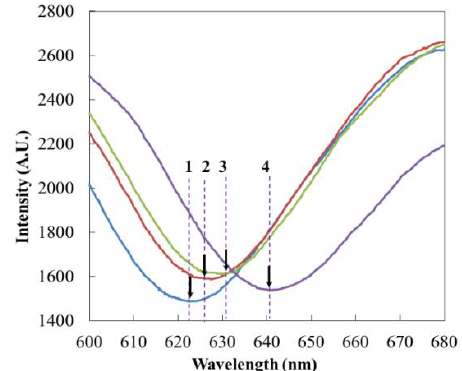
Figure 4. Au NP-amplified immunoassays and the corresponding SPR signals. 1: PBS, 2: Capture antibody, 3: antigen (500 ng/mL CRP), and 4: labelled Ab-AuNPs.